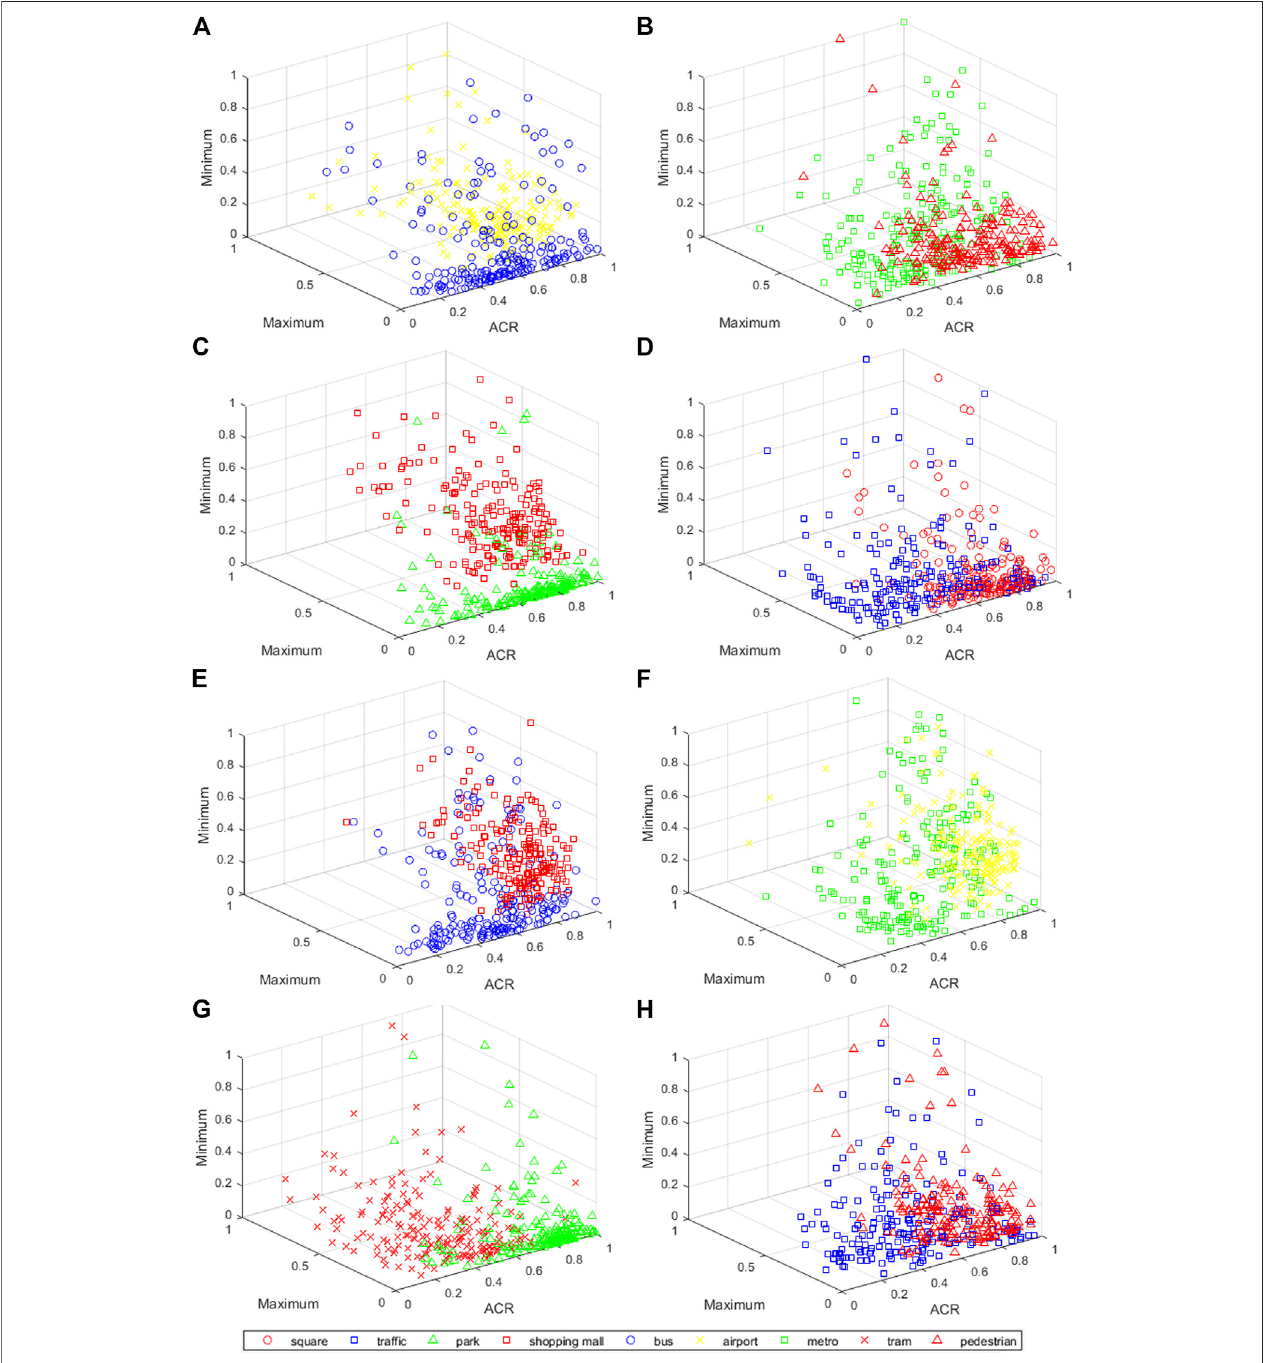
FIGURE8| HACFSfeaturedistributionin3Dspace, (A) IMF1ofbus&airport; (B) IMF1ofmetro&pedestrian; (C) IMF1ofpark&shoppingmall; (D) IMF1ofsquare & traf fi c; (E) IMF2 of bus & shopping mall; (F) IMF2 of met; (G) IMF2 of tram & park; (H) IMF2 of traf fi c & pedestrian.